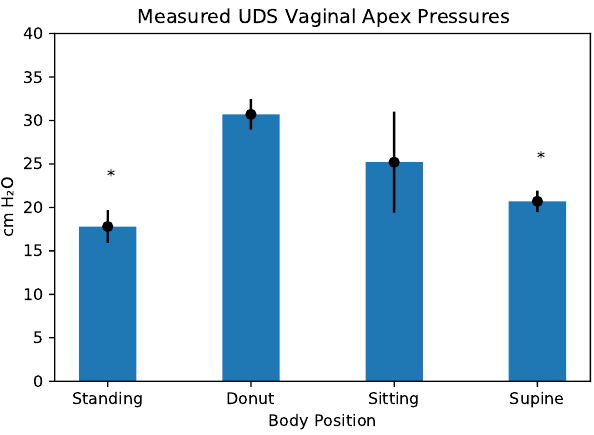
Figure 5. Pressures measured at the vaginal apex in the different positions. Asterisks indicate statistically significant